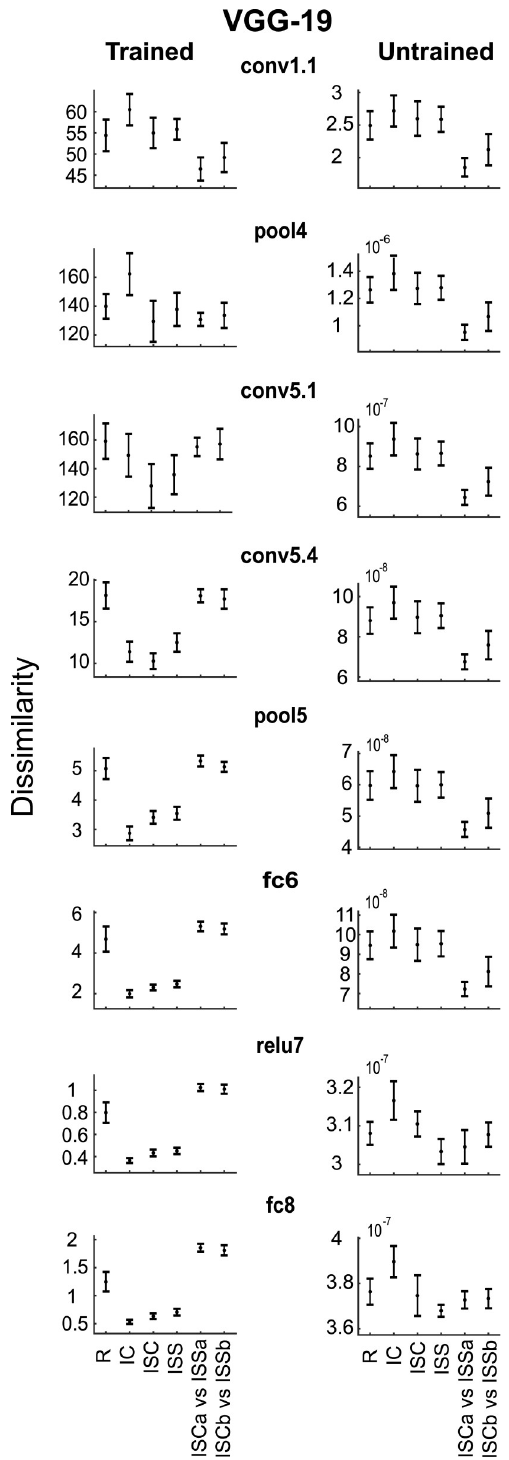
Fig 9. Response dissimilarities for the shape groups: Deep CNN layers. Dissimilarities for groups R, IC, ISC, ISS, “ISCa vs ISSa”, “ISCb vs ISSb” of selected trained (left column) and untrained (right column) versions of VGG-19 layers (same nomenclature as in Fig 2). Same conventions as in Fig 8. The specific selection of layers is motivated by the fact that there were no critical differences in the layers that follow the selected ones.